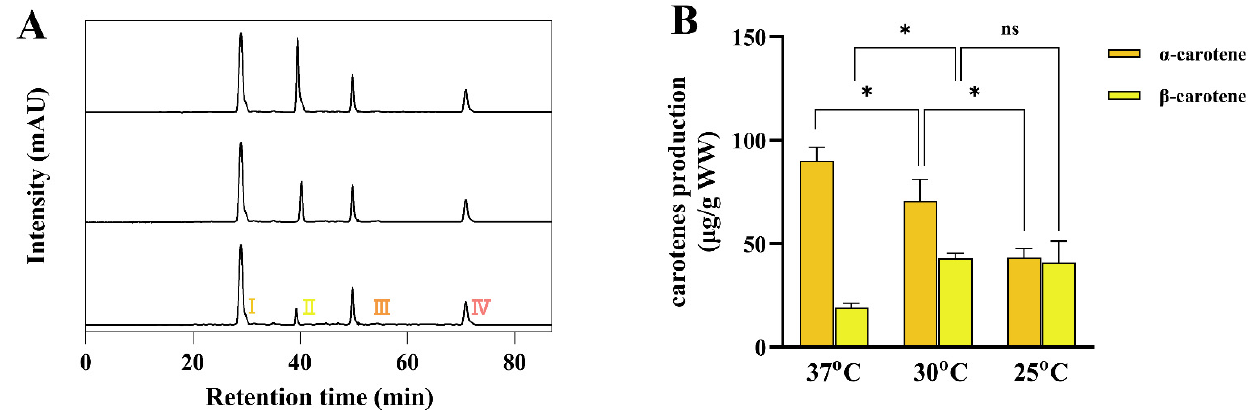
Figure 6. Modulation of distinct temperatures at starting stage to mediate dynamic production of α -/ β -carotenes with different stoichiometries. ( A ) HPLC spectra of lycopene-accumulating strains harboring pBlue- GlpF - TeLCY E and pCspA-TeLCYB with different temperatures cultivation at starting stage and cold shock treatment at end stage. I, α -carotene; II, β -carotene; III, δ -carotene; IV, lycopene. ( B ) α -/ β -carotene-accumulation patterns in lycopene-accumulating strains harboring pBlue- GlpF - TeLCYE and pCspA- TeLCY B with different temperatures cultivation at starting stage and cold shock treatment at end stage. (*) p <